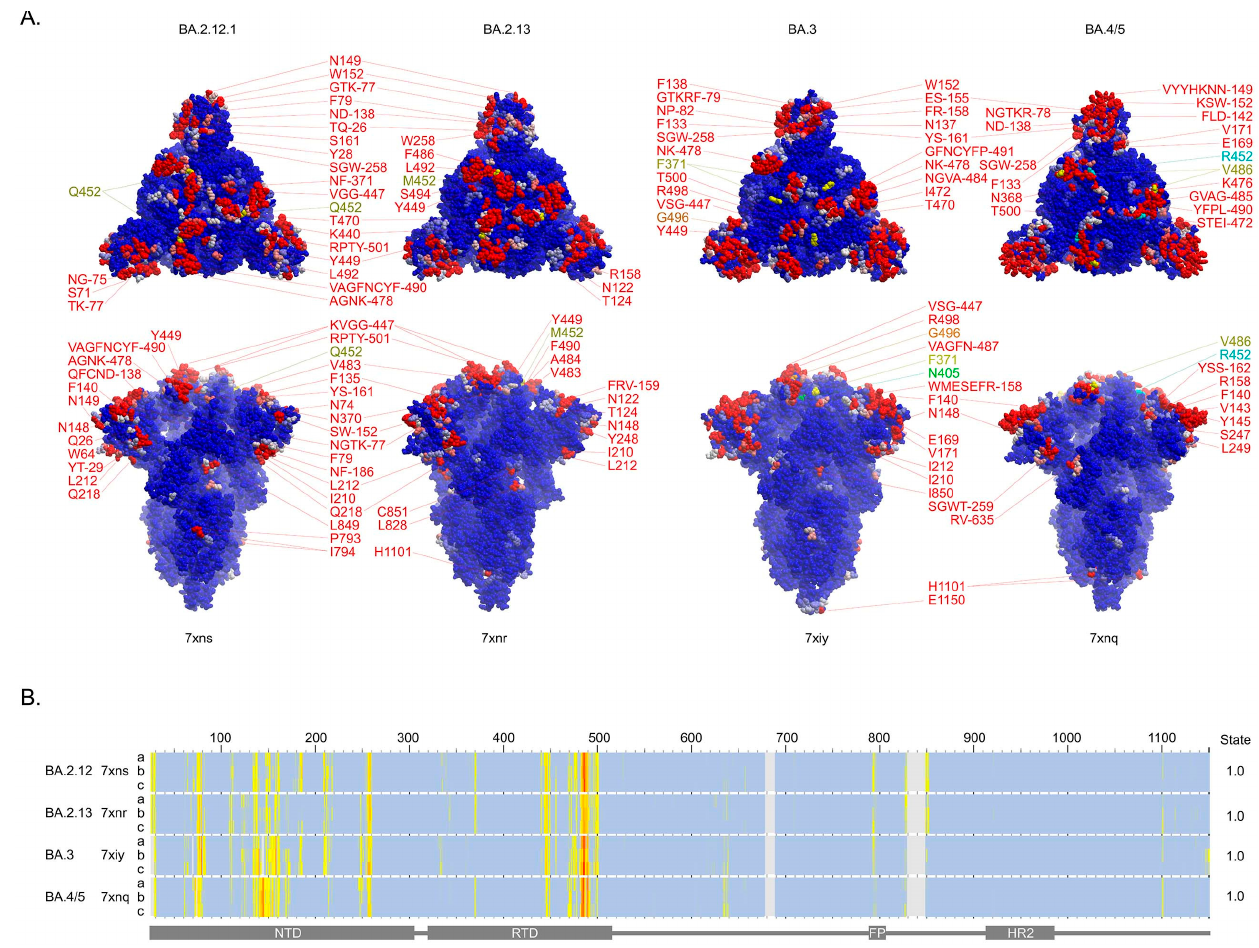
Figure 4. Membrane binding surfaces of closed BA.2.12.1, BA.2.13, BA.3, and BA.4/5 variants spike trimers. ( A ) The residues with moderate (pink) and substantial (red) membrane binding propensities in the closed states of spike trimer structures of the labelled variants are shown in top ( above ) and side ( below ) views of the surfaces. ( B ) Heatmap showing the membrane propensity scores for each residue of each of the three subunits of the closed spike structures, which are labelled along with the numbering of the variant sequences above and the domains beneath.